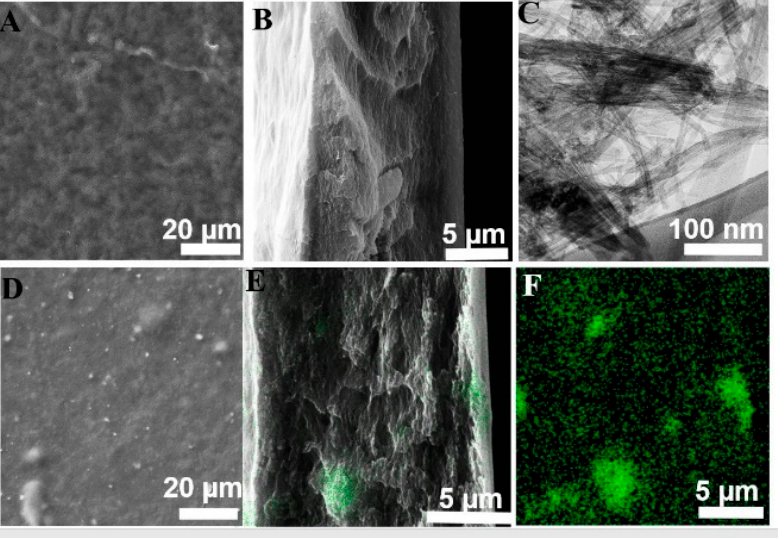
Figure 1. ( A , B ) Surface and cross-section of CTA-CNT; ( C ) TEM image of CNT@TNT; ( D ) SEM of the surface view of CTA-TNT@CNT; ( E ) EDS overlayed cross-section image of CTA-TNT@CNT; ( F ) EDS showing Ti distribution of